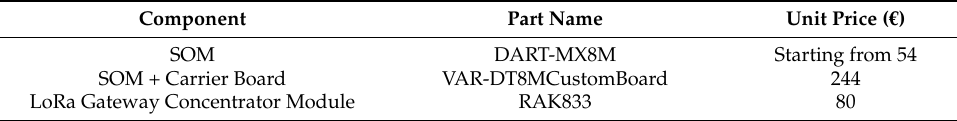
Table 2. Total cost of the Internet of Things (IoT)